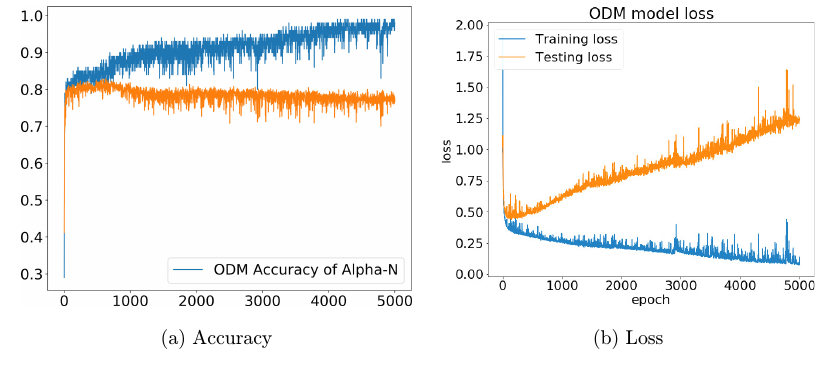
Fig. 5. Accuracy vs. loss observation.